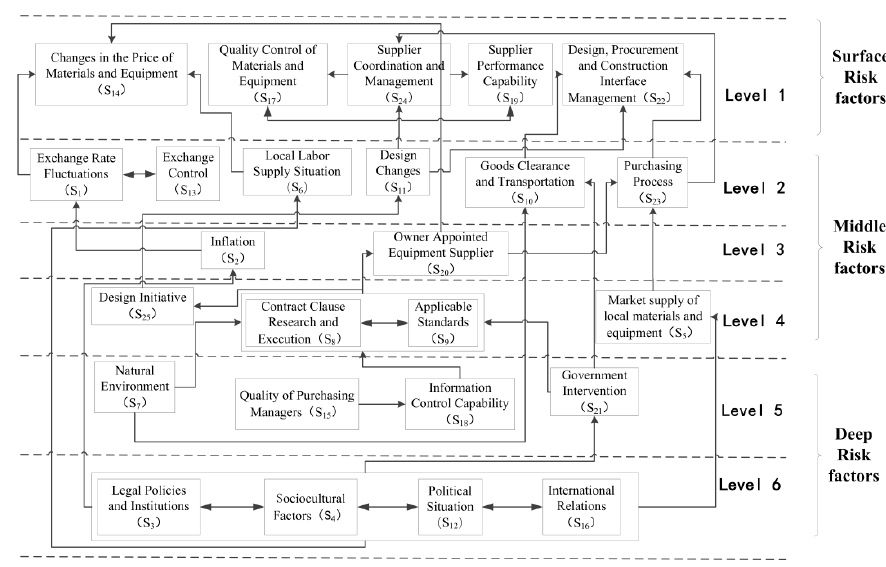
Figure 4. ISM model.